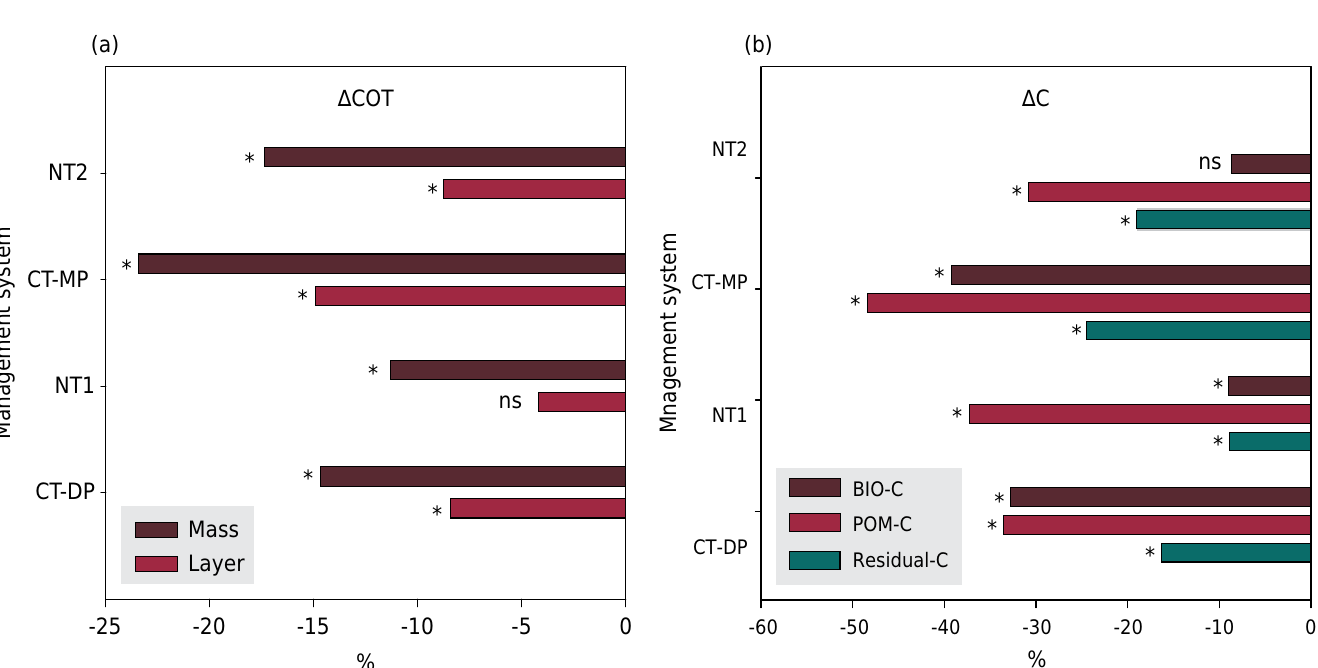
Figure 1. Relative differences of C stock: (a) soil C stock in a clayey Latossolo Vermelho Distrófico (Typic Haplustox) in the 0.00-1.00 m depth range, based on the reference NV. * and ns: significant and not significant, respectively, by the t test (p<0.05). NV: CT-DP, NT1, NT2, CT-MP. Losses are indicated by a minus sign (-). Layer: C stocks calculated by the equivalent layer, without correction for the soil mass equivalent to the natural system of reference [NV]; Mass: C stocks corrected by the mass of soil equivalent to the natural system of reference [NV]. (b) soil C compartments in the 0.00-0.30 m layer, based on the reference NV; BIO-C: microbial biomass; POM-C: particulate organic carbon; residual C = TOC-(POM-C + BIO-C). CT-DP: disk plow; NT1: no-tillage, after the first year with disk plow; CT-MP: moldboard plow; NT2: no-tillage, after the first year with moldboard plow; NV: cerrado sensu stricto protected from